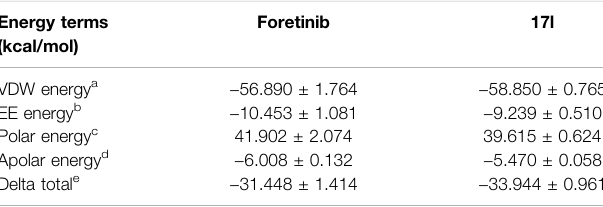
TABLE 3 | Predicted free energies (kcal/mol) for binding of foretinib and 17l to c-Met kinase. Energy terms (kcal/mol)